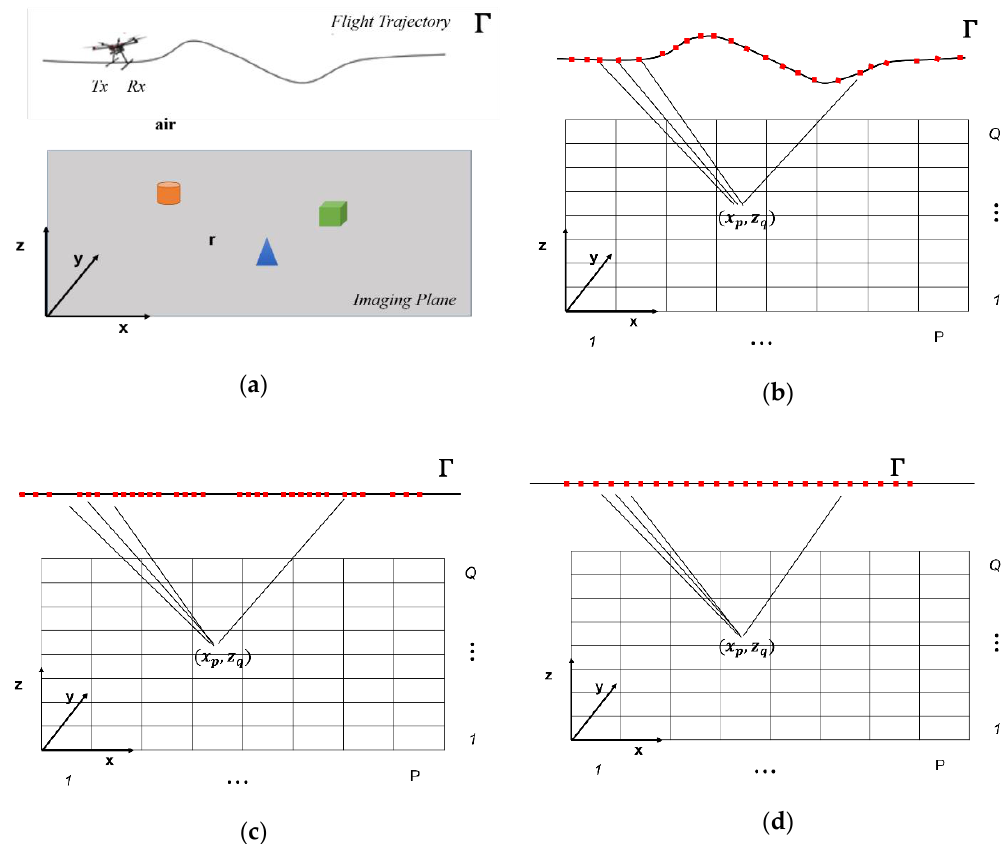
Figure 4. The Unmanned Aerial Vehicle (UAV)-borne radar imaging system, ( a ) actual imaging scenario; ( b ) starting schematic configuration; ( c ) schematic configuration after range alignment; ( d ) schematic configuration after along-track interpolation.